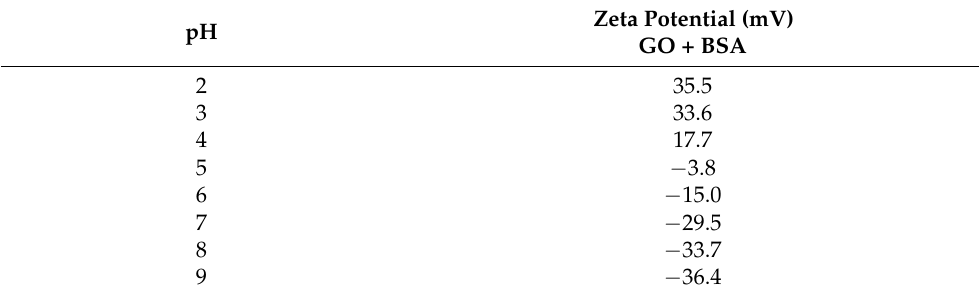
Table 2. Zeta potential measurement of GO suspended in BSA at 0.01 mg/mL and 25 ◦ C.